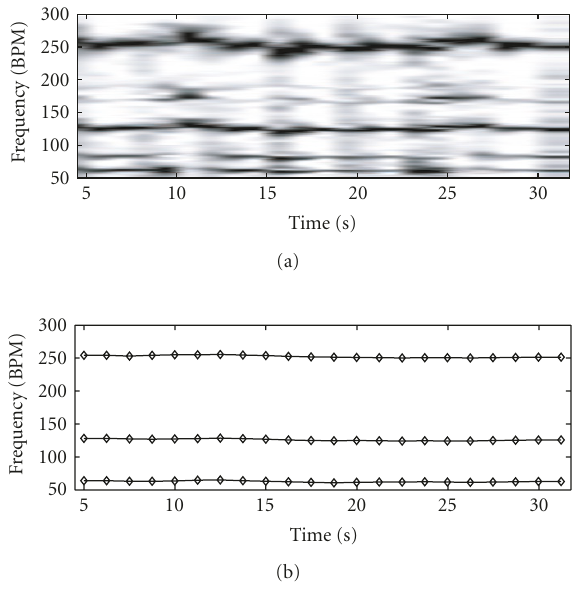
Figure 8: Tracking of the three most salient periodicity paths for Mozart’s Rondo Alla Turca . The relationship among them is 1 : 2 : 4.